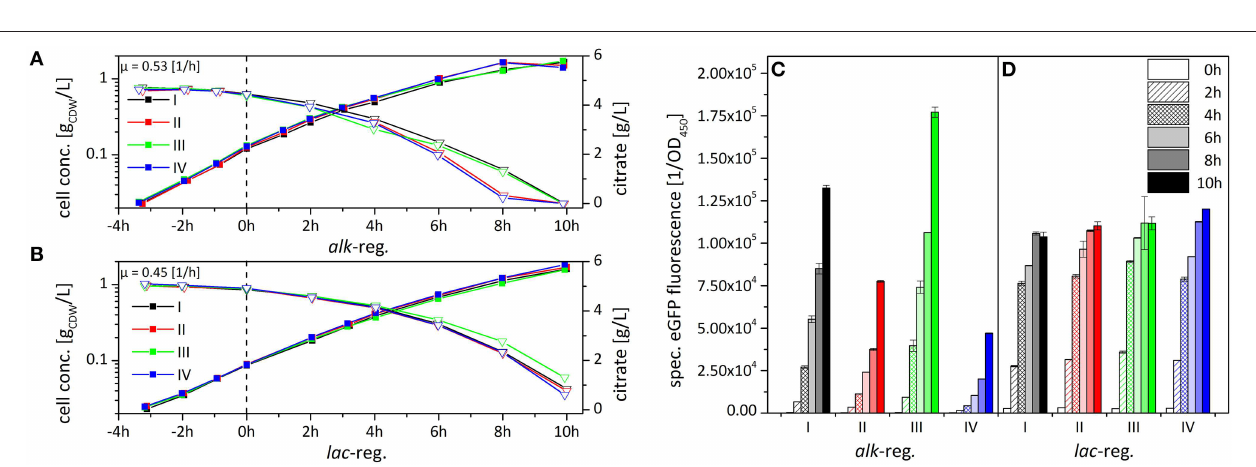
FIGURE 4 | Comparison of growth behavior (A,B) and variability in StyA-eGFP levels (C,D) upon expression under the control of the alk - (A,C) and the lac - (B,D) regulatory systems in P. putida DOT-T1E. Results for 4 representative cultures are shown each for P. putida DOT-T1E (pA-EGFP_B) and P. putida DOT-T1E (pA-EGFP_B_lac) (see text for details on clone selection). Cells were cultivated in M9 * medium supplement with 0.5% (w/v) citrate. Induction was initiated at 0h by the addition of 0.025% (v/v) DCPK or 1mM IPTG for the alk - or the lac -based expression, respectively. The specific fluorescence was determined via eGFP fluorescence measurement and normalization to the cell concentration. Error bars give the standard deviations of two independent fluorescence